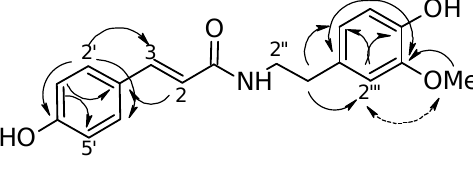
Figure 3. Select g HMBC ( → ) correlations and nOe ( ↔ ) interactions for alkamide 14 .